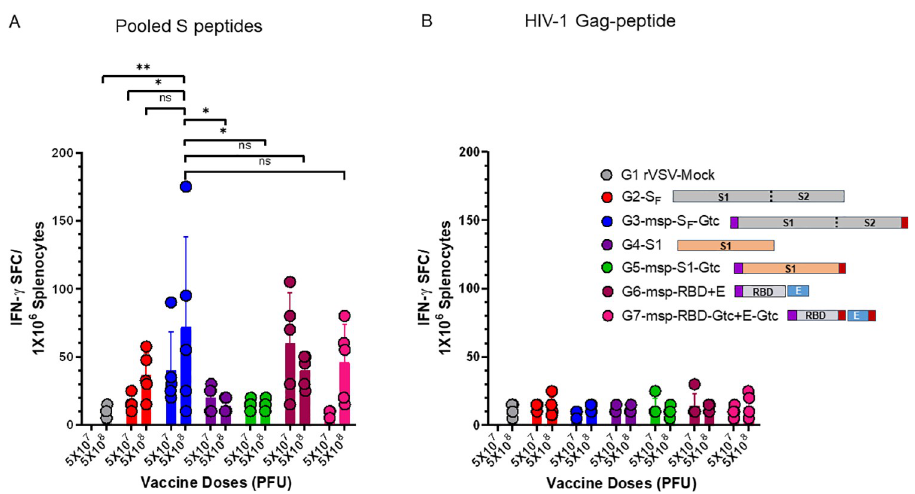
Fig 8. T cell responses against SARS-CoV-2 Spike protein. Mice were primed with rVSV Ind -SARS-CoV-2 followed with rVSV NJ -SARS-CoV-2 two weeks after prime-immunization. Two weeks after the boost-immunization, splenocytes were prepared and stimulated with a PepTivator SARS-CoV-2 Prot_S [ (A) (S5 Fig)], or an irrelevant (control) peptide derived from the HIV Gag (B) . IFN- γ spot-forming units (SFUs) were enumerated by ELISPOT. Statistical significance was determined by two-way ANOVA with Tukey’s correction ( � , p < 0.05; �� , p < 0.005; ns, not significant). Data are presented as mean SFU numbers with error bars representing standard deviation (n = 5 mice per group). Purple box: honeybee msp, red box: VSV Gtc. VSV-Mock denotes VSV vector alone without any gene insert.